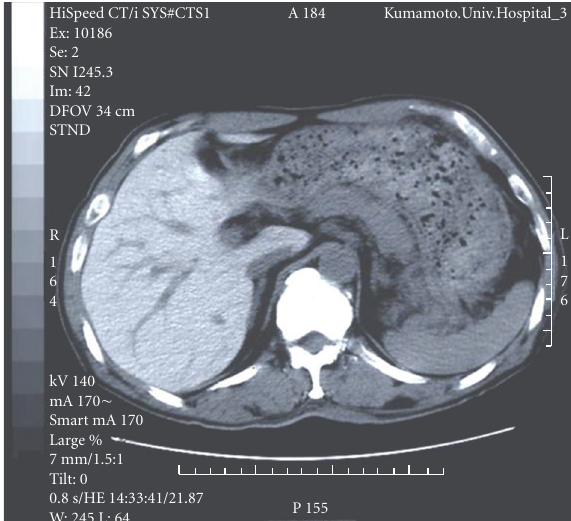
Figure 1: Abdominal computed tomographic scanning through liver and spleen. Note the marked increase in liver density (113 Hounsfield units) compared to the spleen.